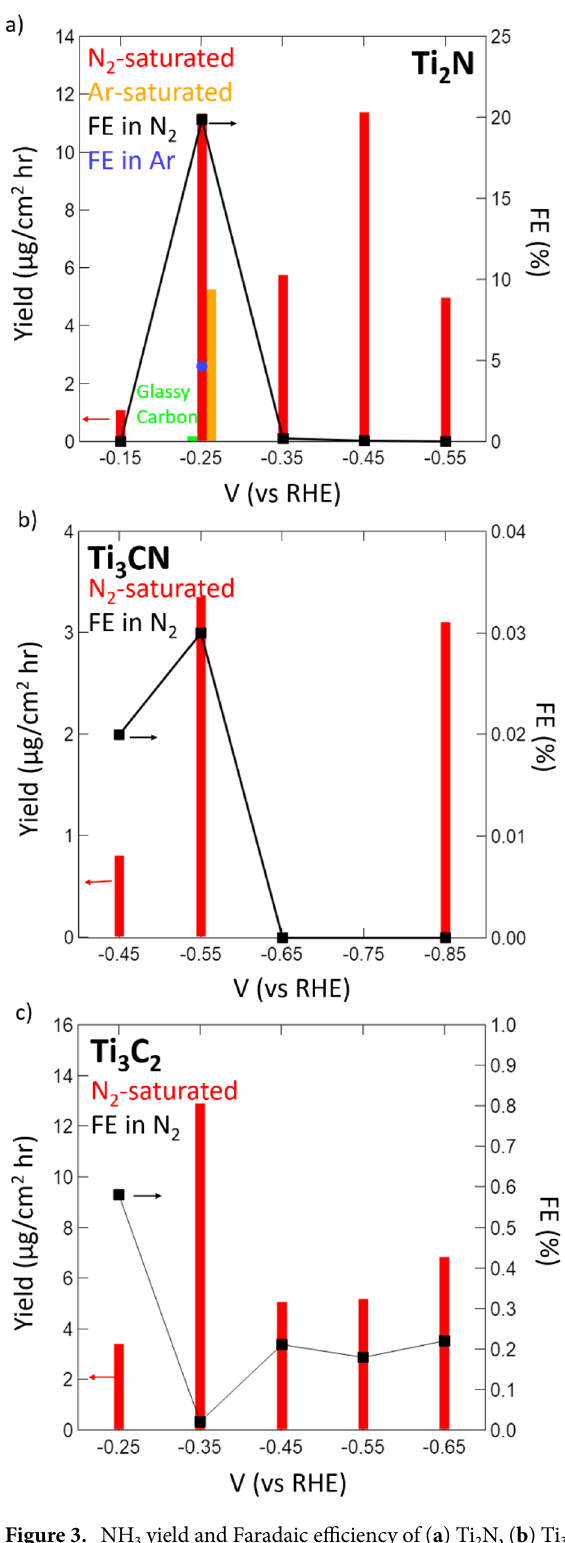
Figure 3. NH 3 yield and Faradaic efficiency of ( a ) Ti 2 N, ( b ) Ti 3 CN, and ( c ) Ti 3 C 2 MXenes at differing potentials after 4-h chronoamperometry experiments. An experiment was carried out in Ar-saturated electrolyte on Ti 2 N MXene to provide evidence of MvK mechanism. All bars correspond to yield values (read to the left) while lines with markers correspond to FE values (read to the